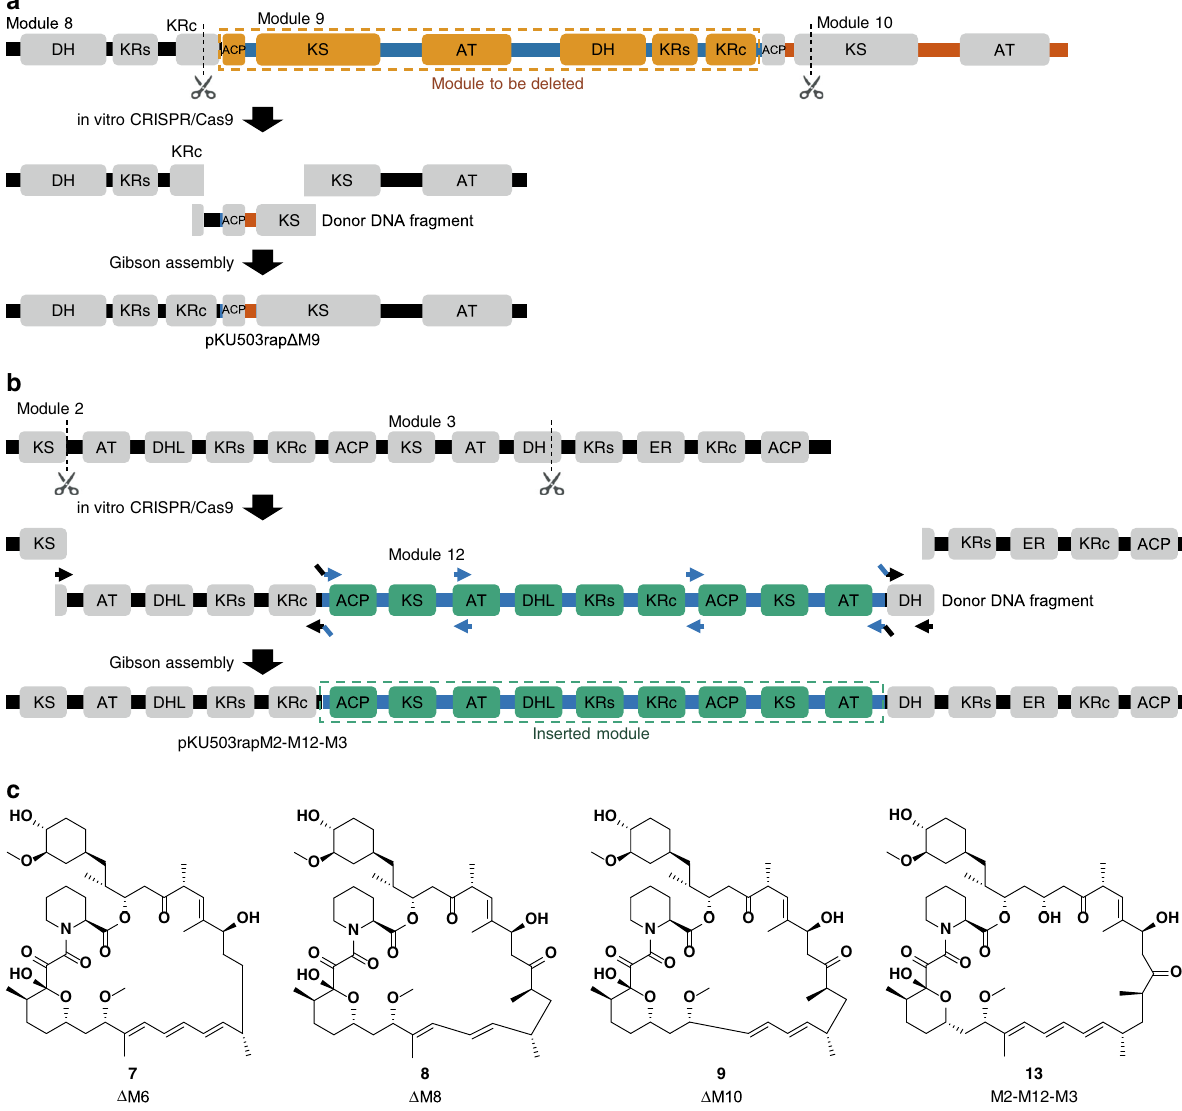
Fig. 2 Module deletion and insertion. Schematic representations of module deletion ( a ) and insertion ( b ). c Rapamycin derivatives produced in this